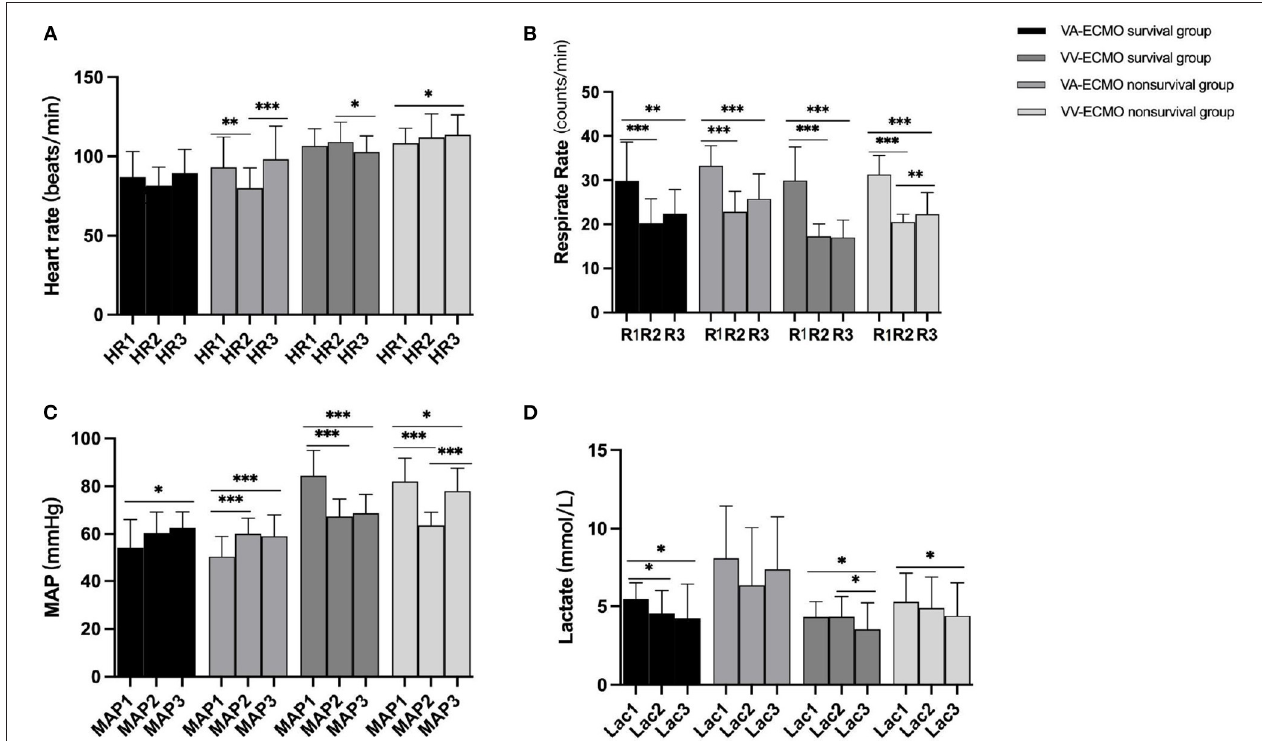
FIGURE 3 | (A–D) Intra-group comparison of three time point (1 = before ECMO boarding; 2 = after ECMO boarding and patient’s condition is relatively stable; 3 = transported to the hospital). * indicate P < 0.05, ** P < 0.01, and *** P < 0.001, respectively.